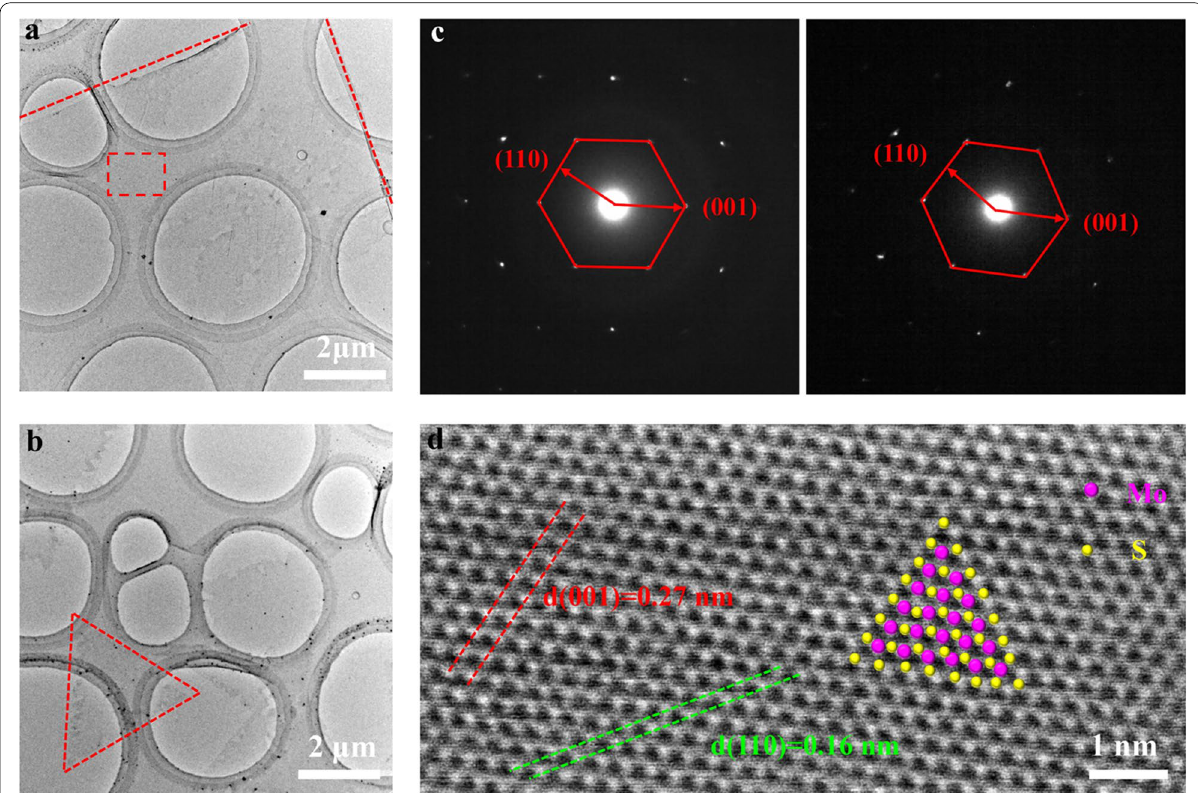
Fig. 2 a , b Bright-field TEM images of the MoS 2 flakes with the belt-like and triangle shape after transferred on a carbon-coated copper grid. The geometrical contour is labeled by the red rectangle and triangle, respectively. c The left and right panels are the SAED patterns from a and b , respectively. d The HRTEM image of the center region (the dashed line rectangle of a ) of the MoS 2 belt structure from a , wherein an atomic model of ML